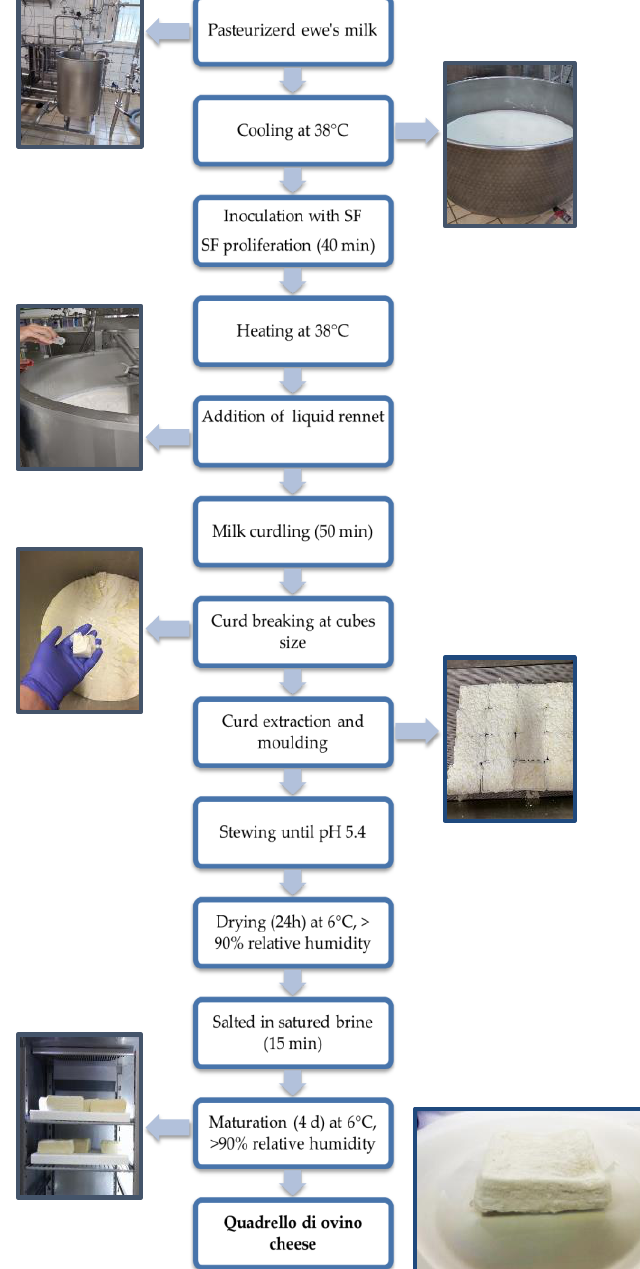
Figure 1. Flow diagram set up for this study to produce “Quadrello di ovino” cheese. Abbreviations: SF, starter formulations.